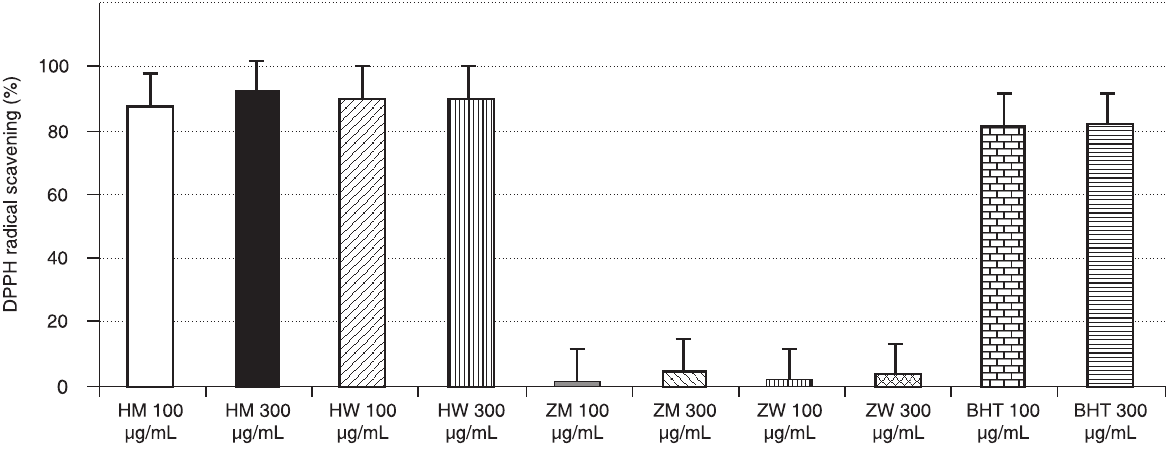
Figure 1. 2,2-Diphenyl-1-picrylhydrazyl (DPPH) radical scavenging activity. H = Hasanbey apricot cultivar; Z = Zerdali apricot cultivar; M = methanol extract; W = water extract; BHT = butylated